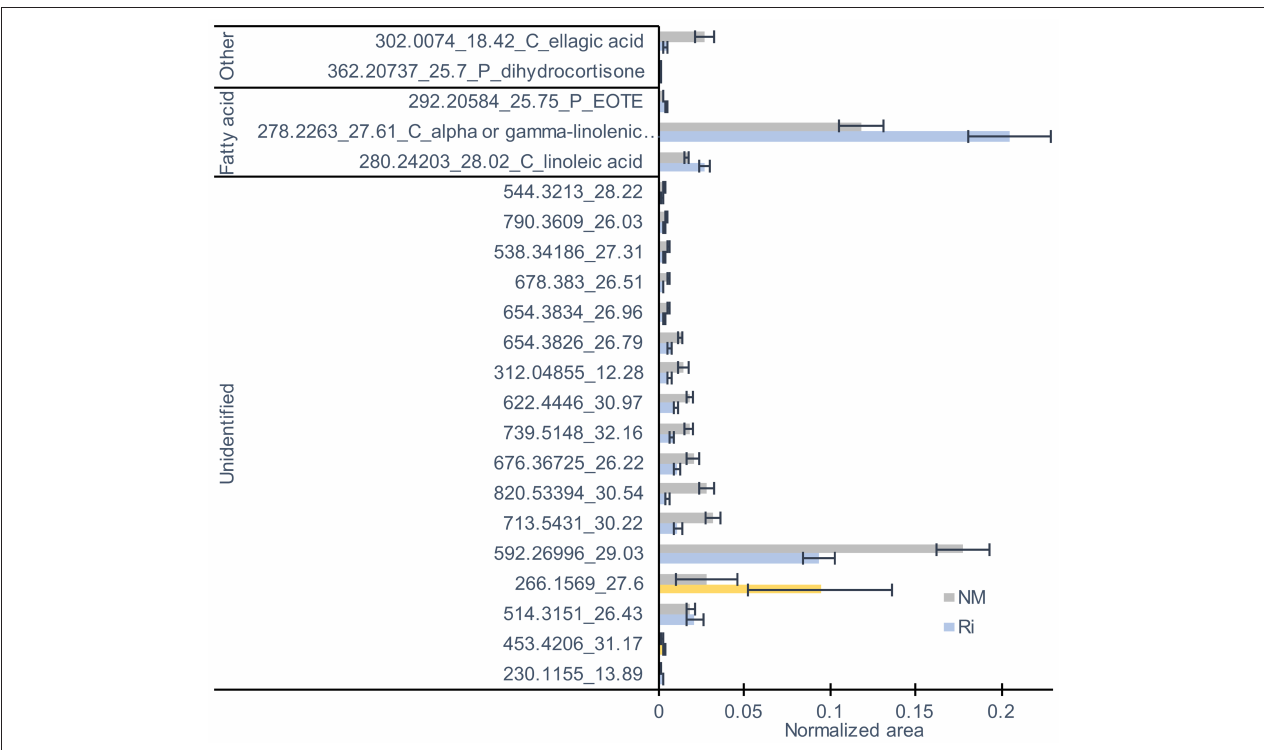
FIGURE 7 | LC-MS metabolites significantly altered by the mycorrhization in leaves. Contents are expressed as normalized areas for each metabolite. Data are the mean ± SE of 14 independent biological replicates for the NM condition and 11 for the Ri condition. Metabolites significantly different between NM and Ri conditions were identified with a fold change of at least + /– 1.5 and a p value < 0.05 (in blue) or a p value < 0.1 (in yellow, Wilcoxon